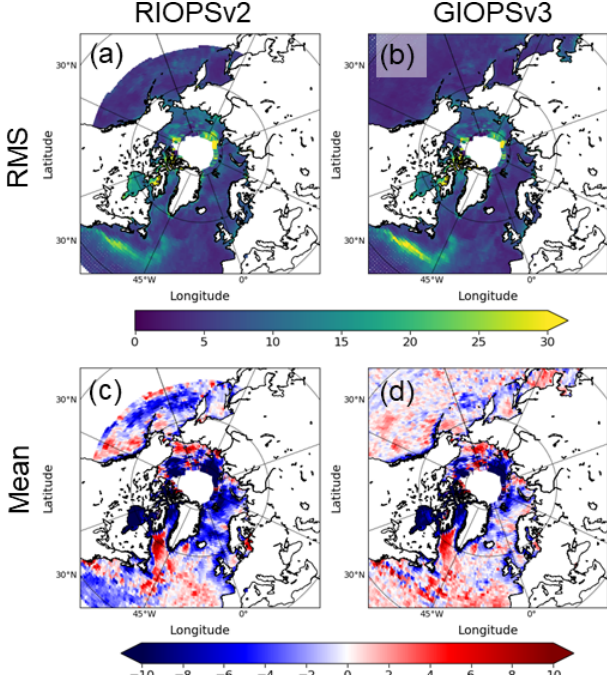
Figure 7. Innovation (observation–model) statistics of sea level anomaly for the period 1 January 2016 to 31 December 2018. The rms (a, b) and mean differences (c, d) are shown for RIOPSv2 (a, c) and GIOPSv3 (b, d)